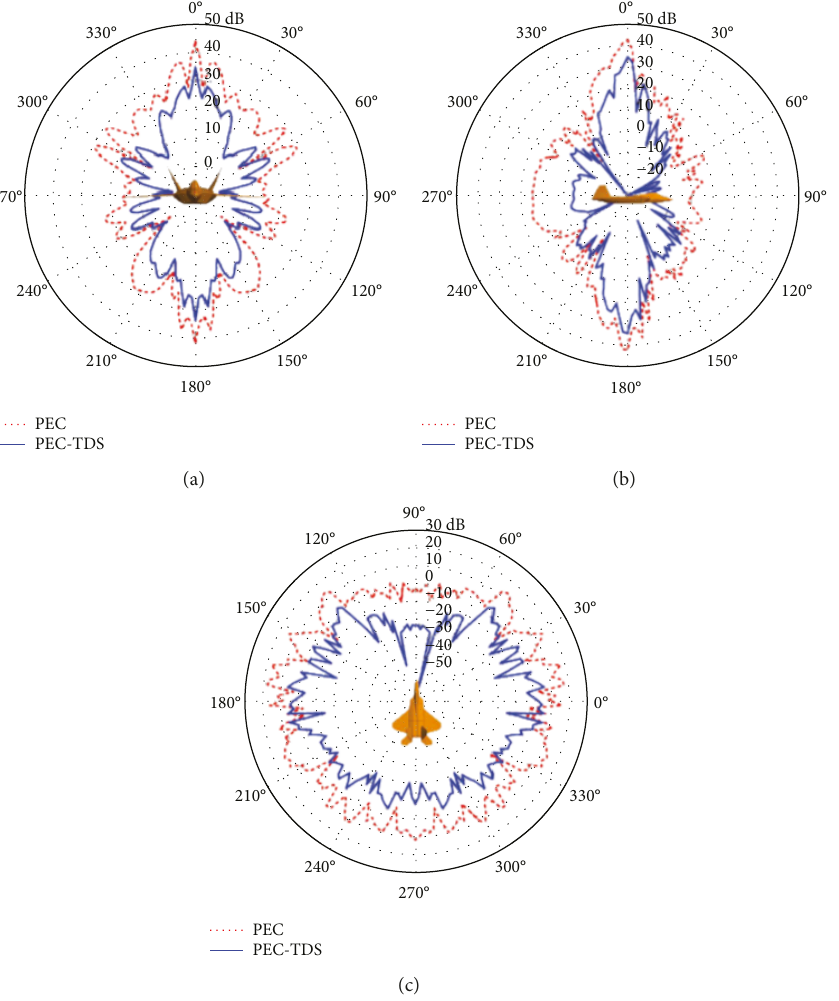
Figure 6: Monostatic RCS of a dielectric coated aircraft for phi-polarization. (a) xz plane. (b) yz plane. (c) xy plane.